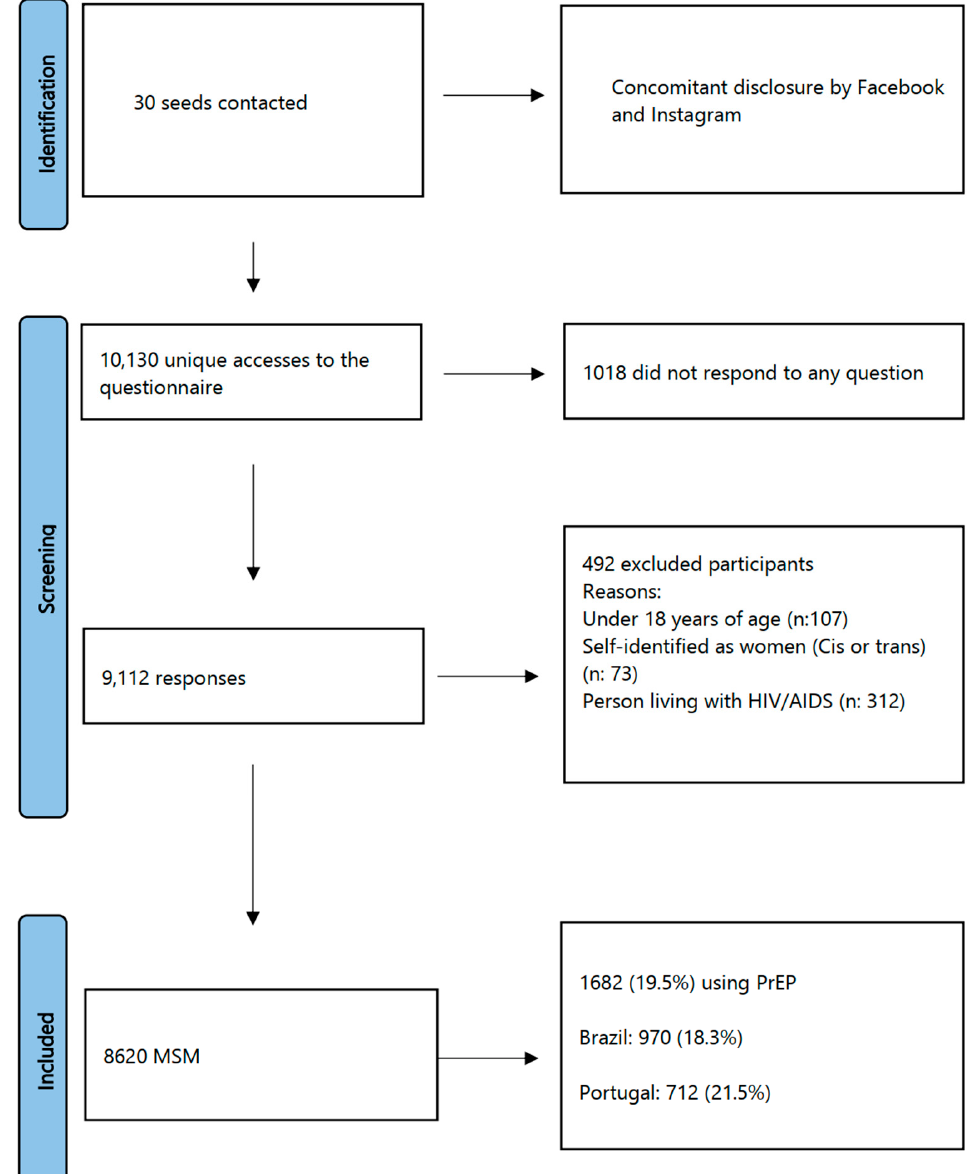
Figure 1. Flowchart of the selection and inclusion of the participants.